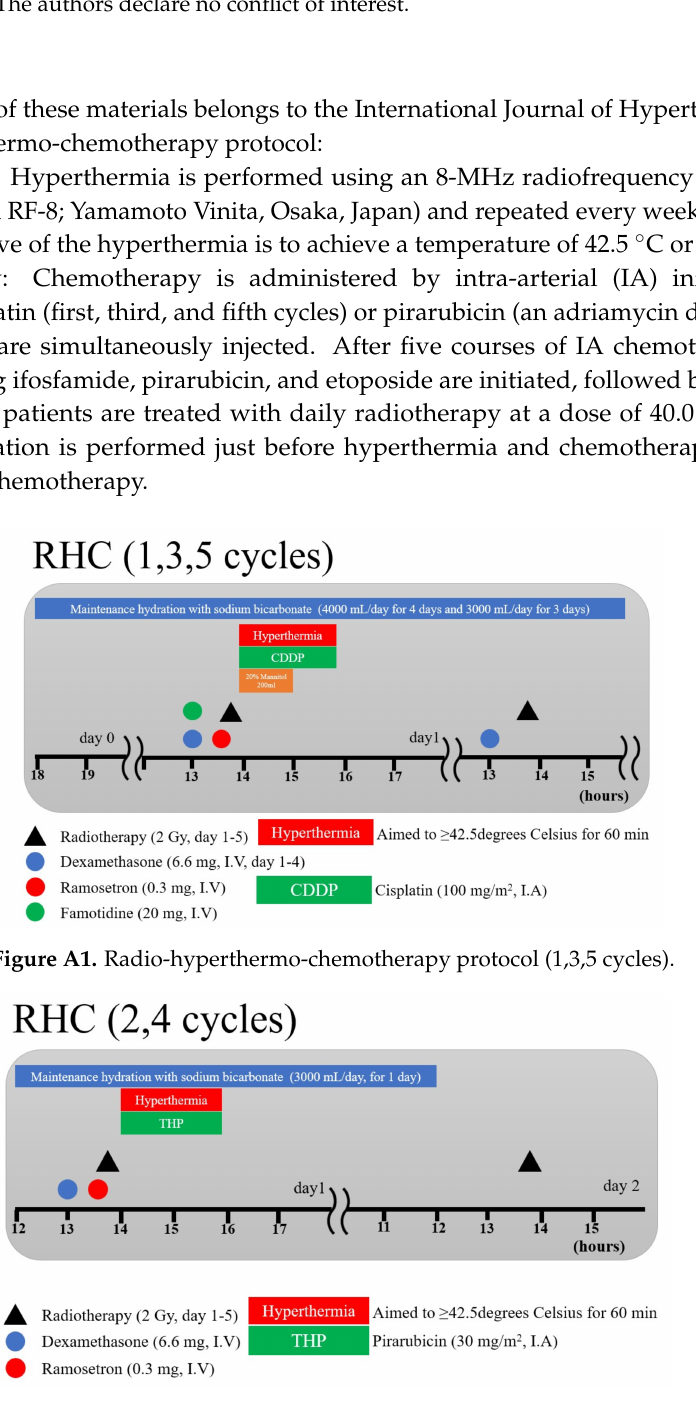
Figure A2. Radio-hyperthermo-chemotherapy protocol (2,4